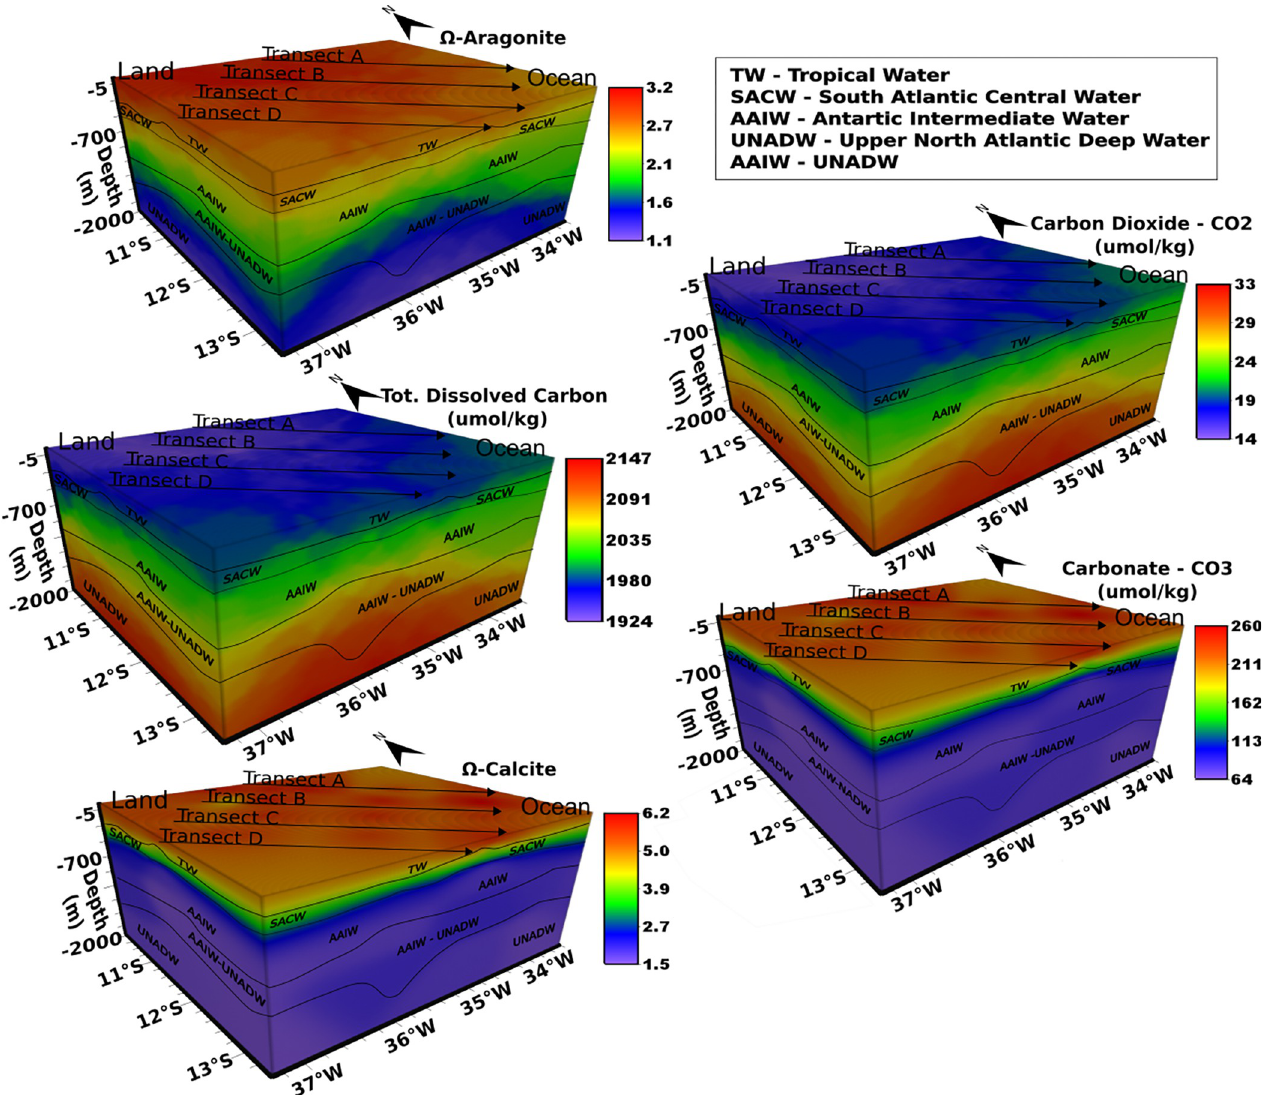
Fig 4. Aragonite saturation state (S-Aragonite), carbon dioxide, total dissolved carbon (DIC), carbonate, and calcite saturation state (S-Calcite) from sampling transects: From the internal platform to the abyssal plain.